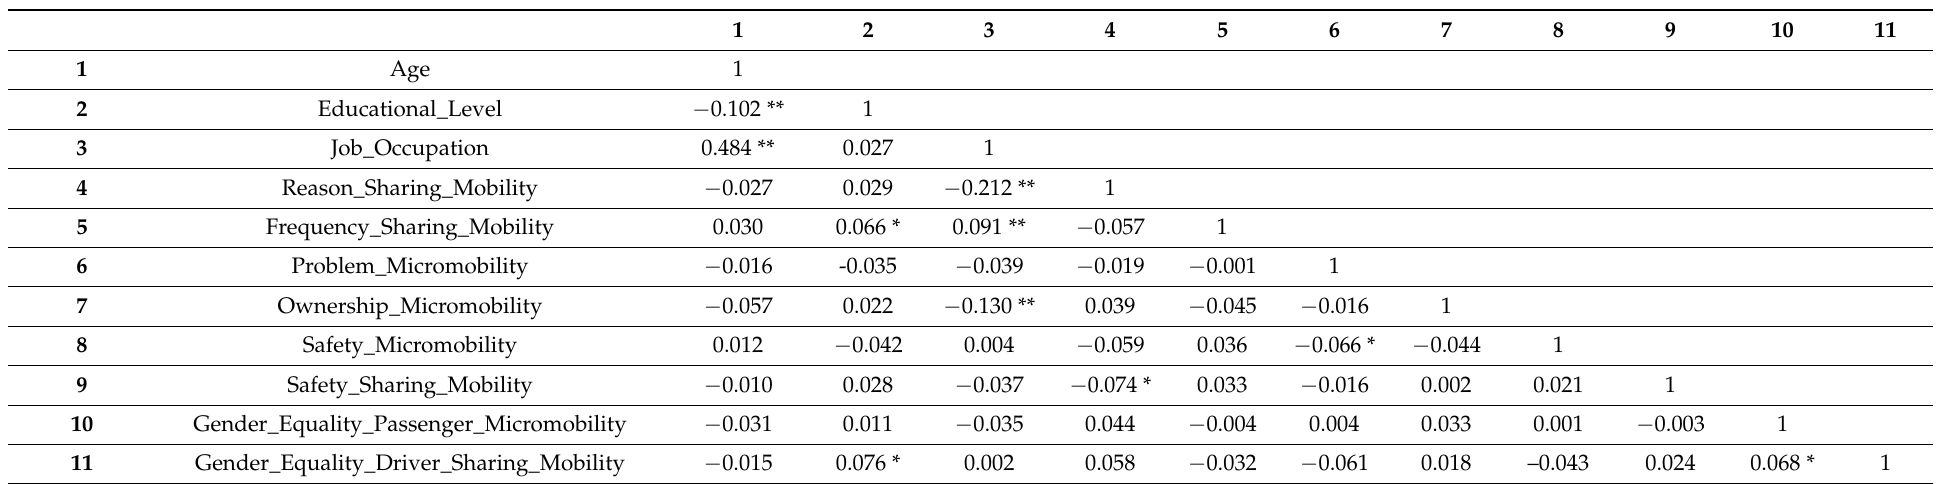
Table 3. Correlation